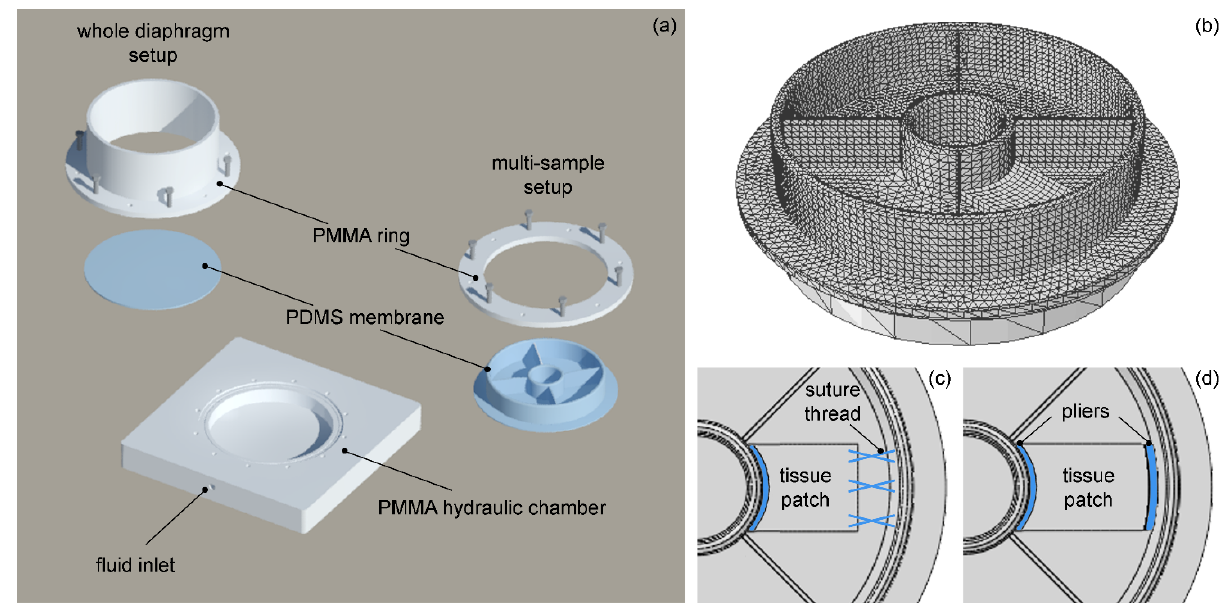
Figure 1. Scheme of the bioreactor structure ( a ). Finite Element (FE) model of the bioreactor top membrane with a tissue patch ( b ). Top view of the tissue patch attached to the membrane with suture thread ( c ) or pliers ( d ).